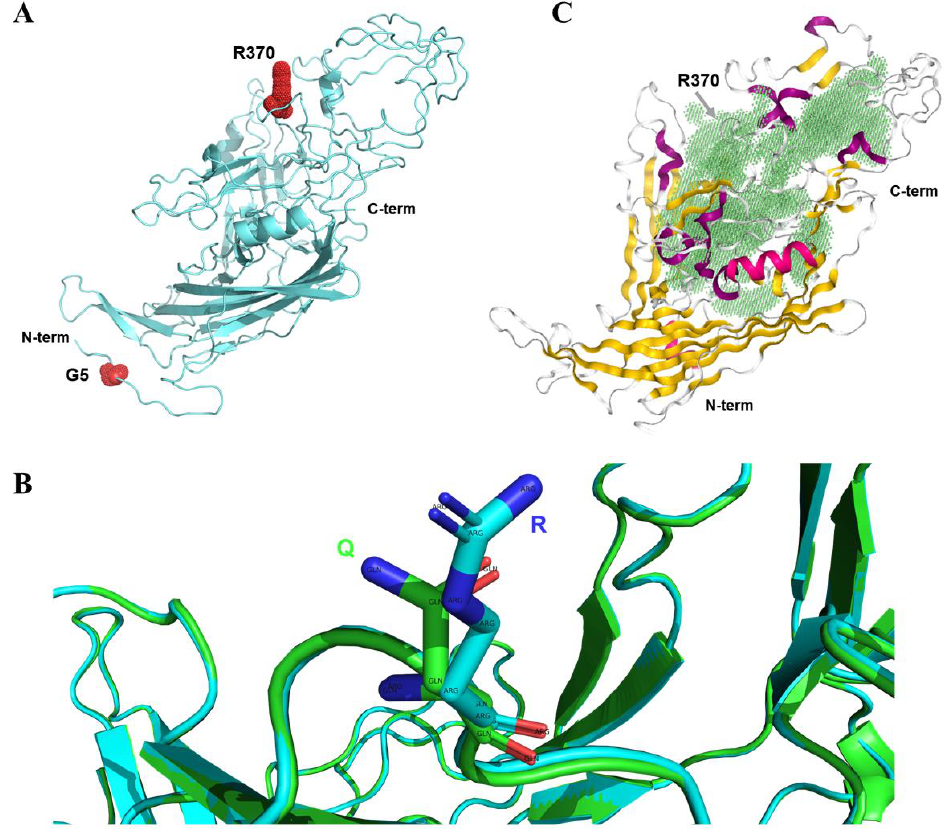
Figure 7. Three-dimensional structure analysis of the mutant VP2 protein. ( A ) VP2 structure of the A5G and Q370R double mutations. The mutated amino acid sites are labeled using red spheres. ( B ) Comparison of the three-dimensional protein structures of the prototype and the Q370R mutant VP2 using PyMOL software. ( C ) The protein-binding pocket of VP2 is predicted. The cavity of the pocket is filled with green color.